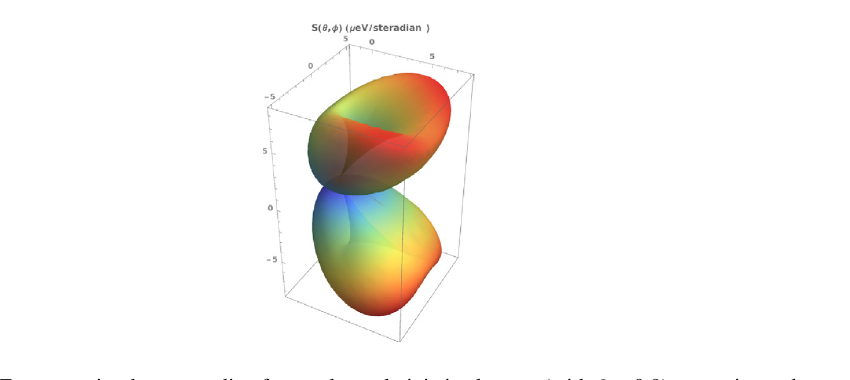
10 − 12 s) travelling in the xz plane, at an angle ×